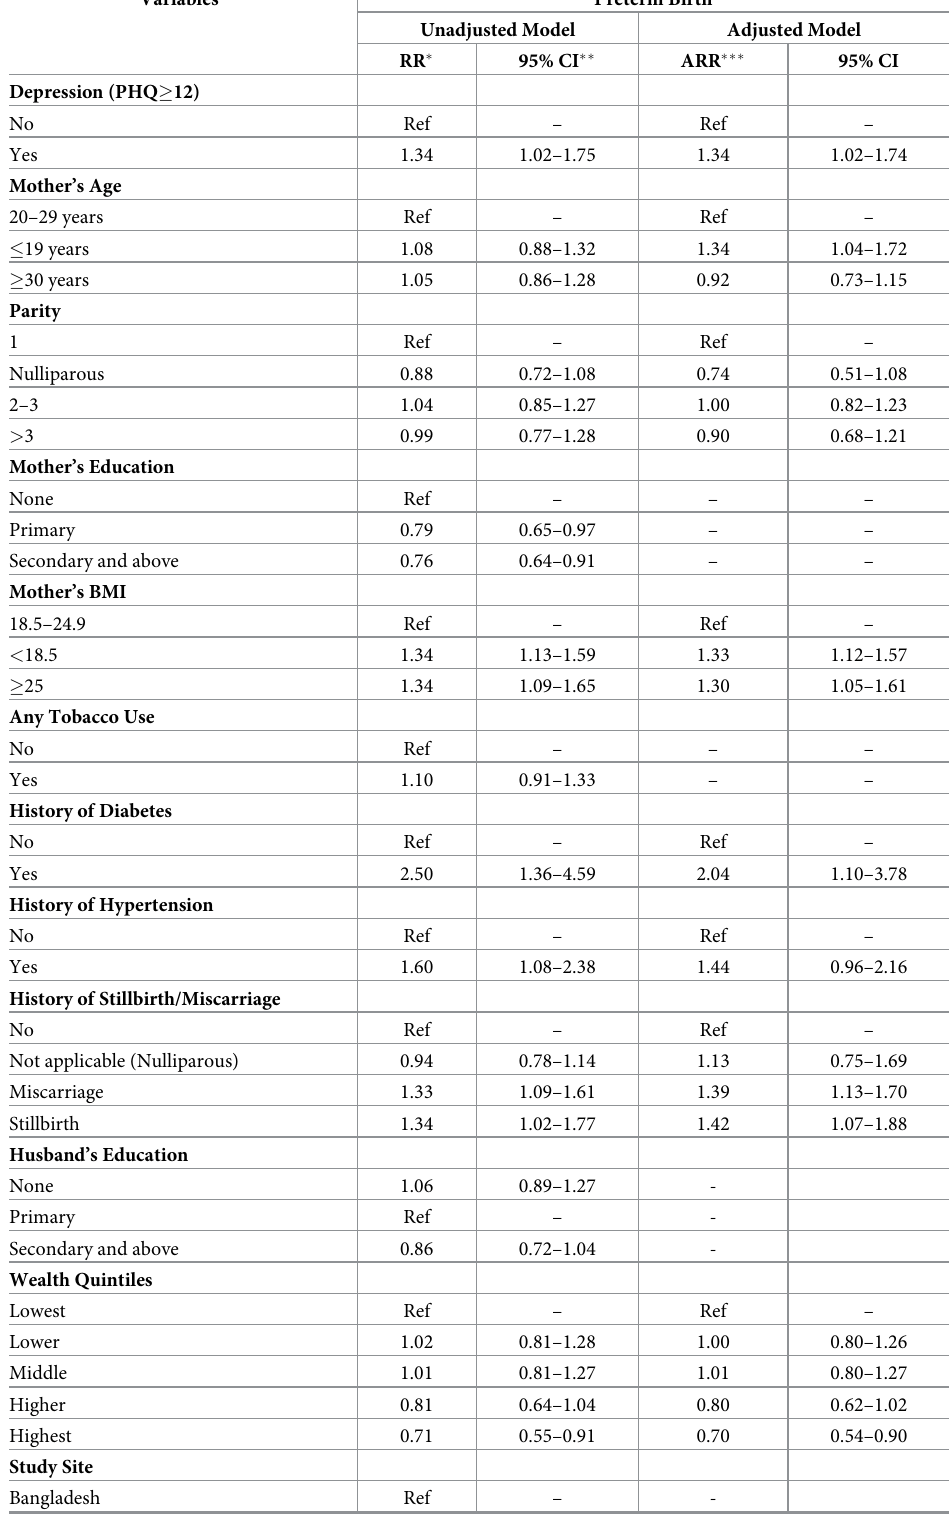
Table 3. Risk ratios for factors associated with preterm birth including maternal antenatal depression (PHQ-9 �